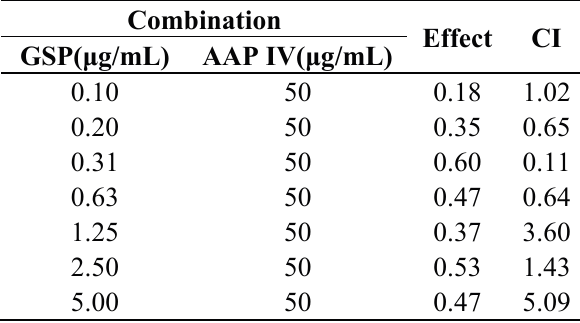
Table 2. Effect and CI of GSP and AAP IV combination on viability of